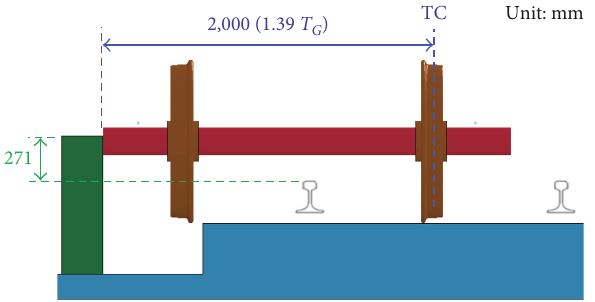
Figure 12: Overview of distance effect